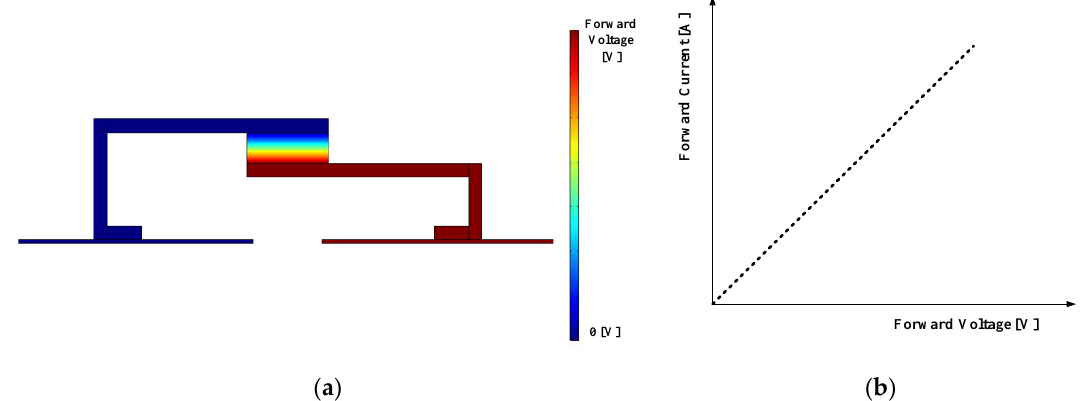
Figure 5. Example of simulation result: ( a ) Forward Voltage for specific current; ( b ) Forward Current dependency on Forward Voltage.